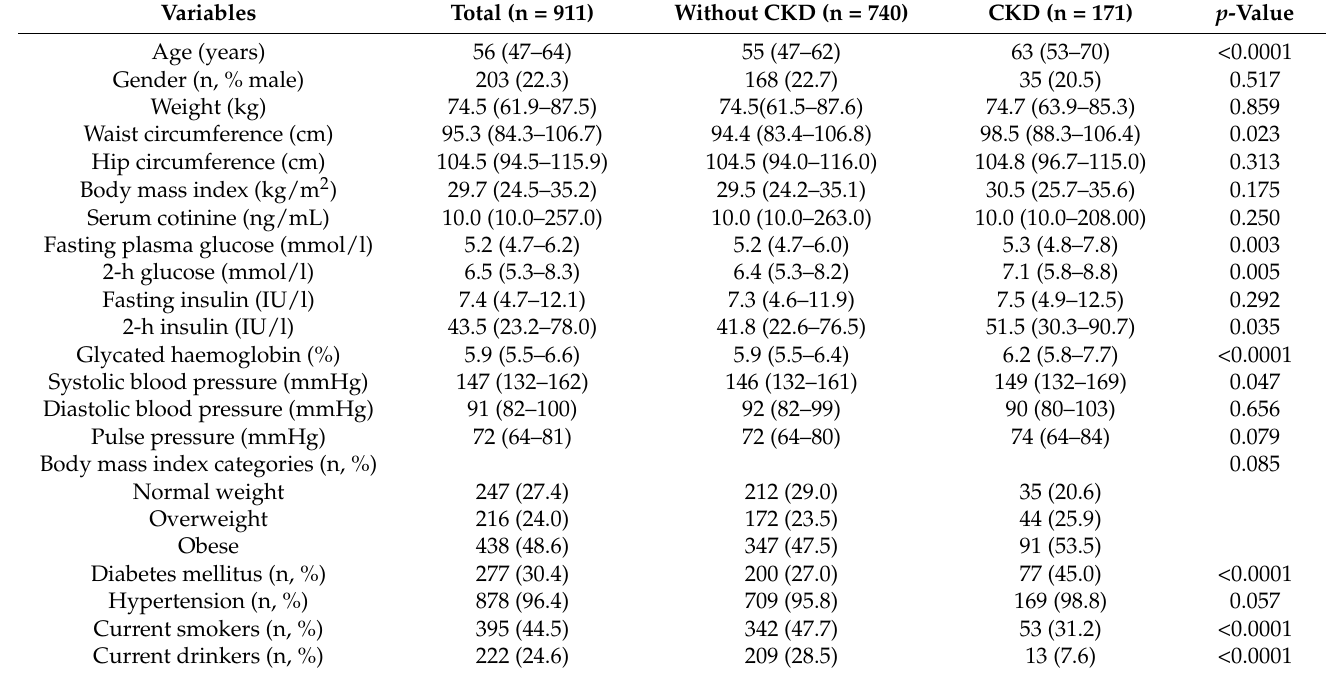
Table 1. General characteristics of the study participants at risk of developing CKD, categorized by CKD